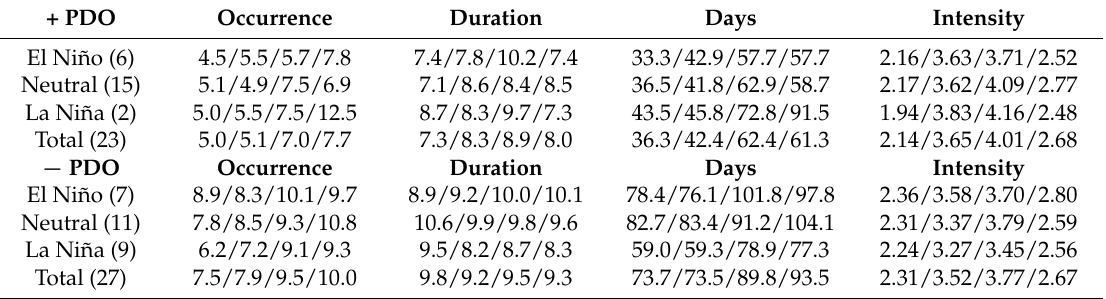
Table 6. As in Table 5, except the NH blocking events were separated by season (Su/F/W/Sp). +